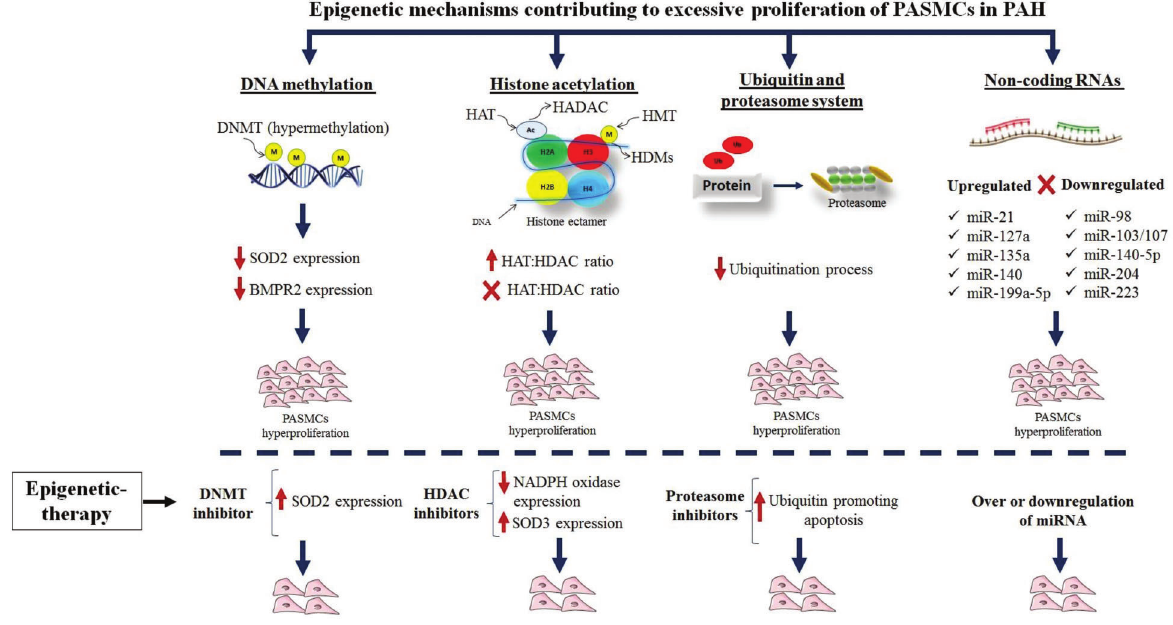
Figure 1. Epigenetic mechanisms contributing to excessive proliferation and resistance to apoptosis of pulmonary artery smooth muscle cells (PASMCs) in pulmonary arterial hypertension (PAH) include: i ) DNA methylation via DNA methyltransferases (DNMTs); ii ) histone modi fi cations, mainly methylation and acetylation, regulated by histone acetyltransferases (HATs) histone methyltransfereses (HMTs), histone deacetylases (HDACs), and histone demethylases (HDMs). Dysregulation of the ubiquitination process, as well as of microRNAs (miRNA, miR-) also participates in the pathogenesis of PAH. Epigenetic therapy based on DNMT inhibitors, HADAC inhibitors, proteasome inhibitors, and miR-RNA modulators are able to reduce the PASMCs proliferative state in